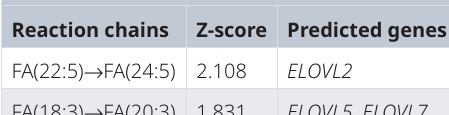
• Liver dataset: https://osf.io/zd4as/ Extended data Open Science Framework: BioPAN: a web-based tool to explore